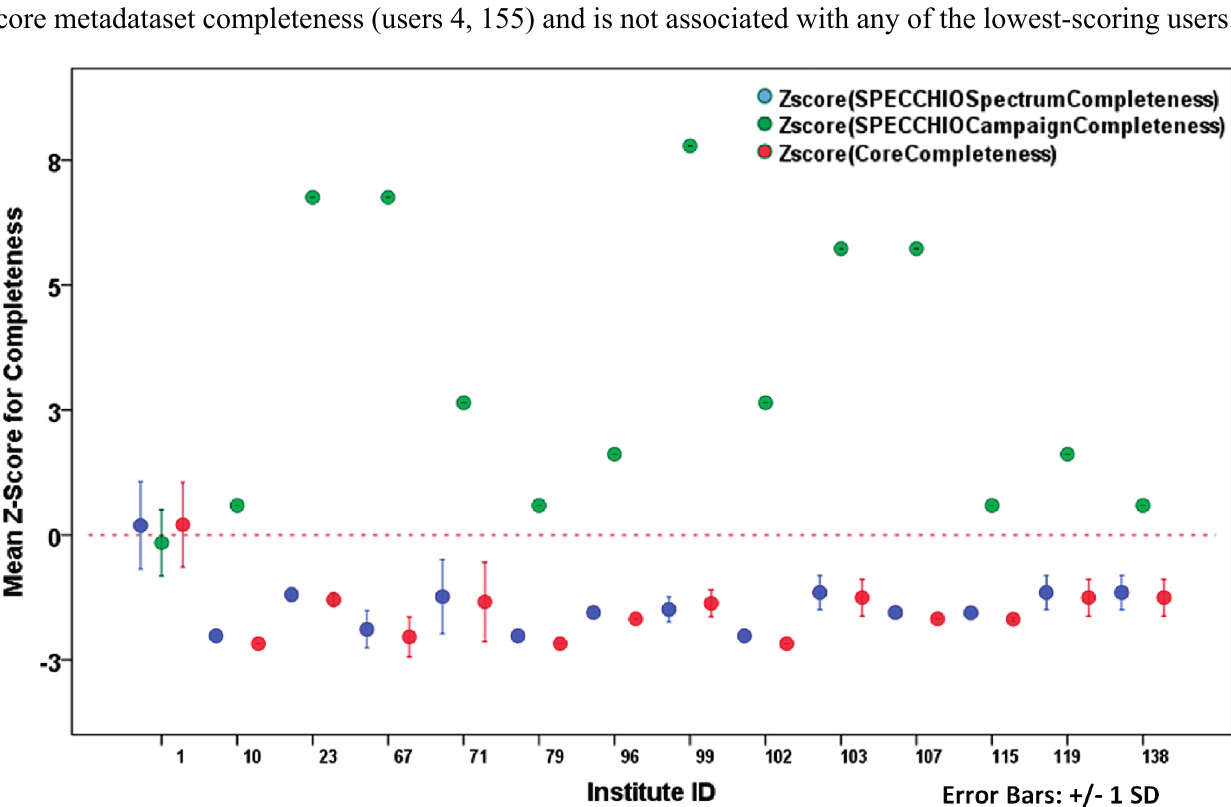
Figure 2. Mean Z-scores for completeness by